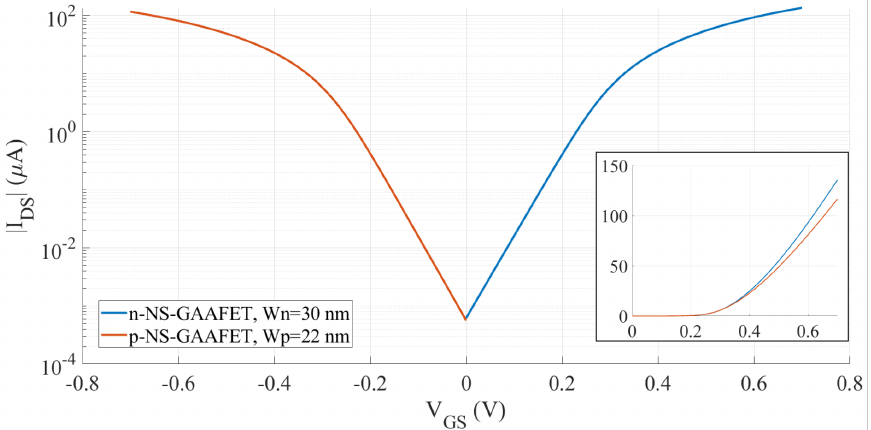
Figure 4. Optimized NS-GAAFET transcharacteristics I DS ( V GS ): n-type ( W n = 30 nm)—blue curves; p-type ( W p = 22 nm)—orange curves; the inset highlights the same NS-GAAFET transcharacteristics I DS ( V GS ) in linear